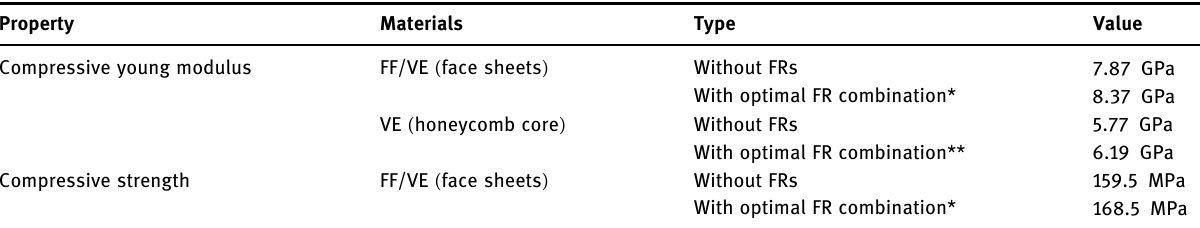
Table 4: Compression test results for the FR and non - FR materials used in the face sheets and core